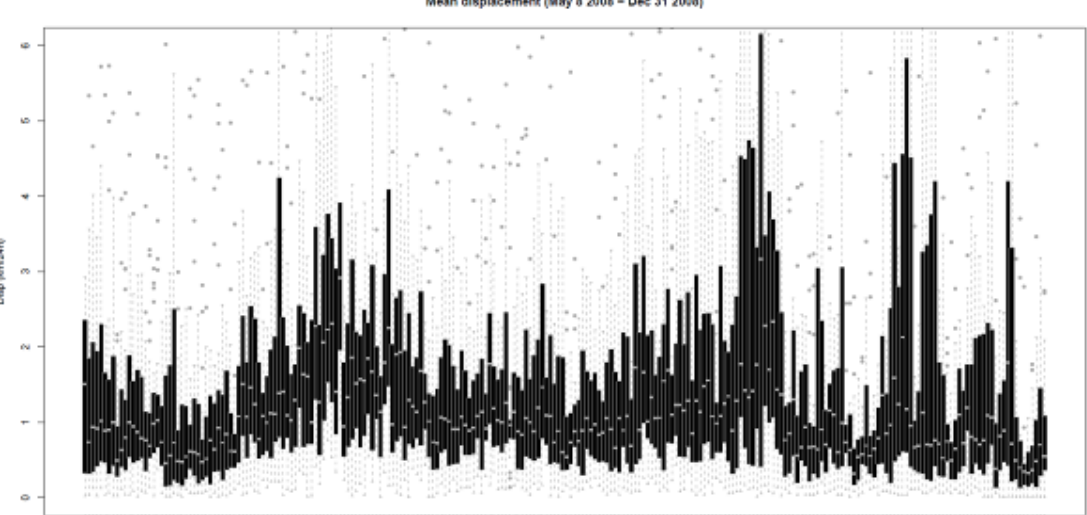
Fig. 2. Average displacement distances May 2008 to December